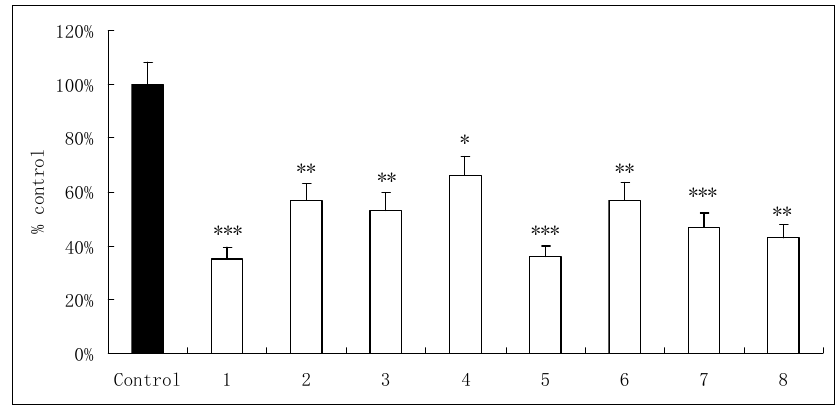
Figure 2. The inhibitory effects of compound 1-8 on the resorption pit area on bone slices formed by osteoclasts in